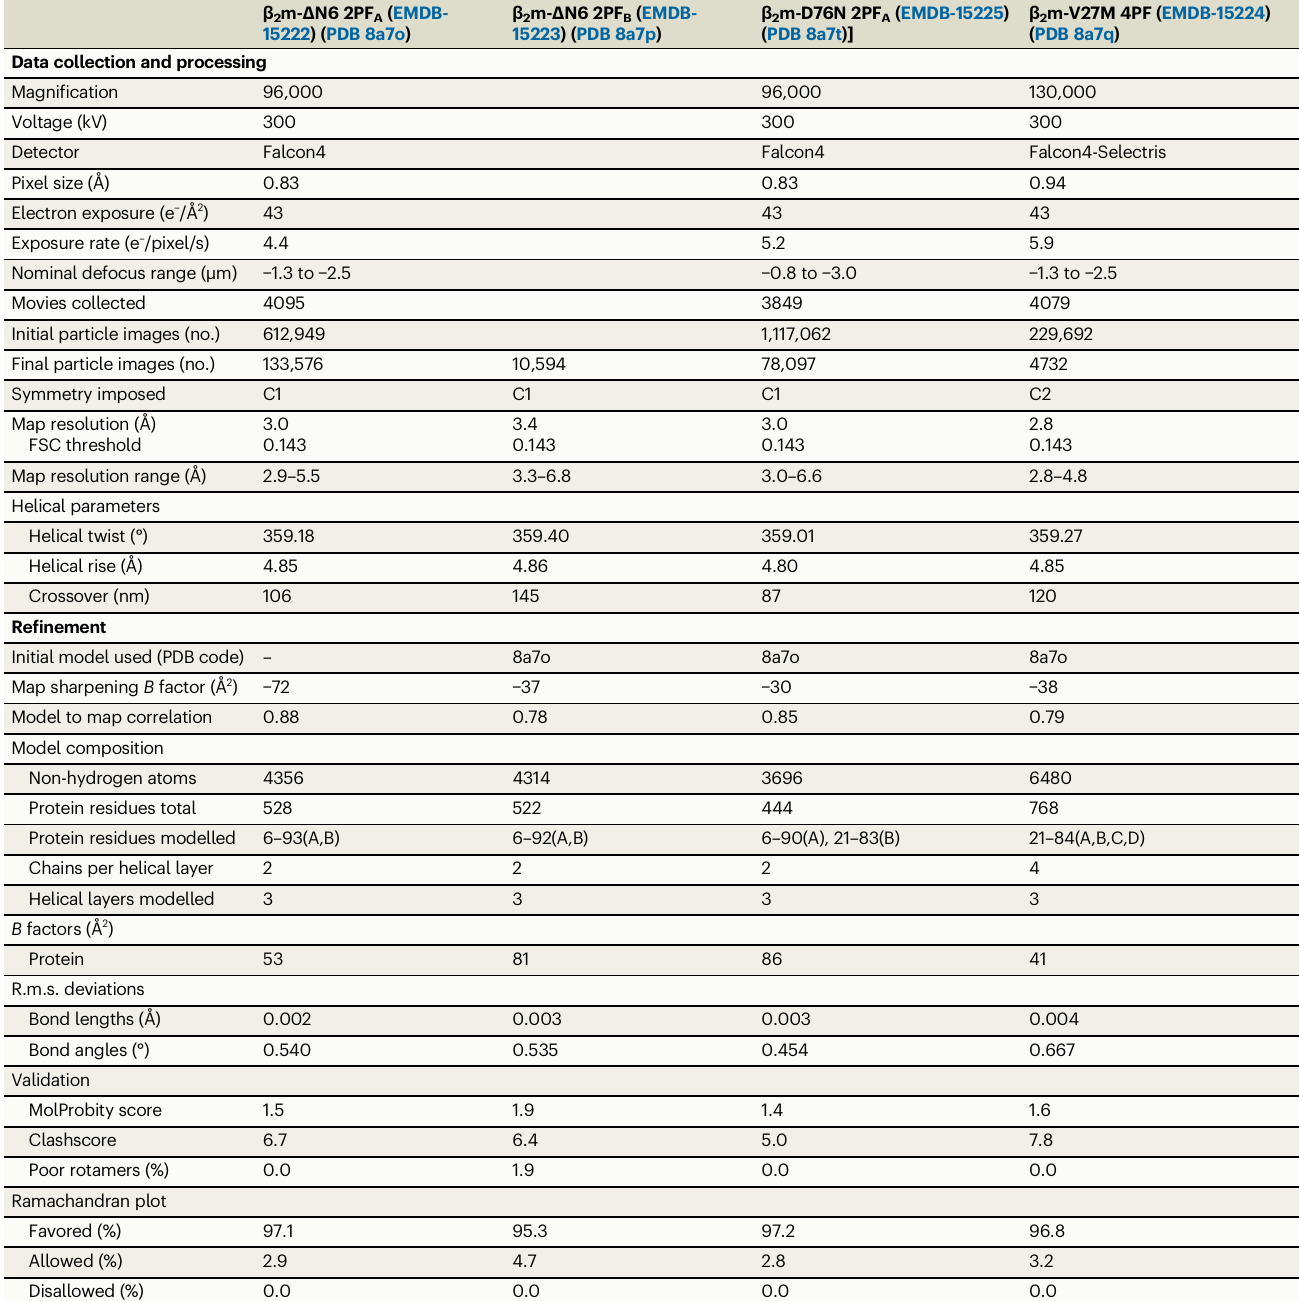
Table 1 | Cryo-EM data collection, re fi nement and validation statistics for the β 2 m DN6